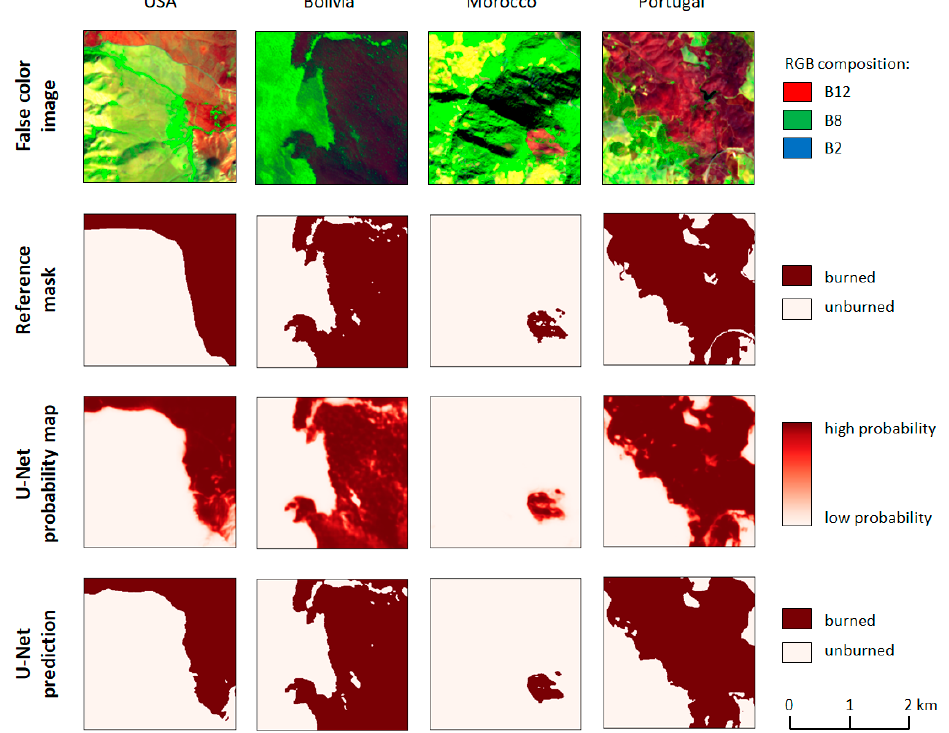
Figure 6. Examples of four test tiles with respective false color composite of the B12, B8 and B2 spectral bands, reference mask, U-Net probability map and final U-Net prediction.